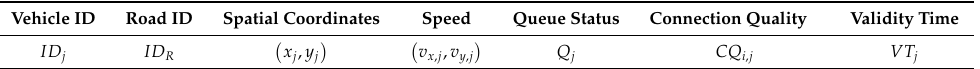
Figure 4. Hello message broadcast. Table 2. Neighbor table